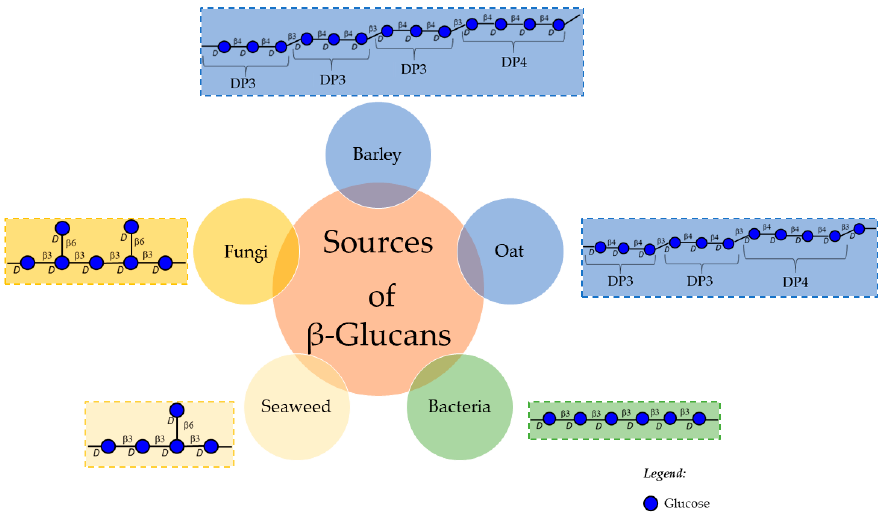
Figure 2. Schematic representation of β -glucans from different origins highlighting their structure diversity.